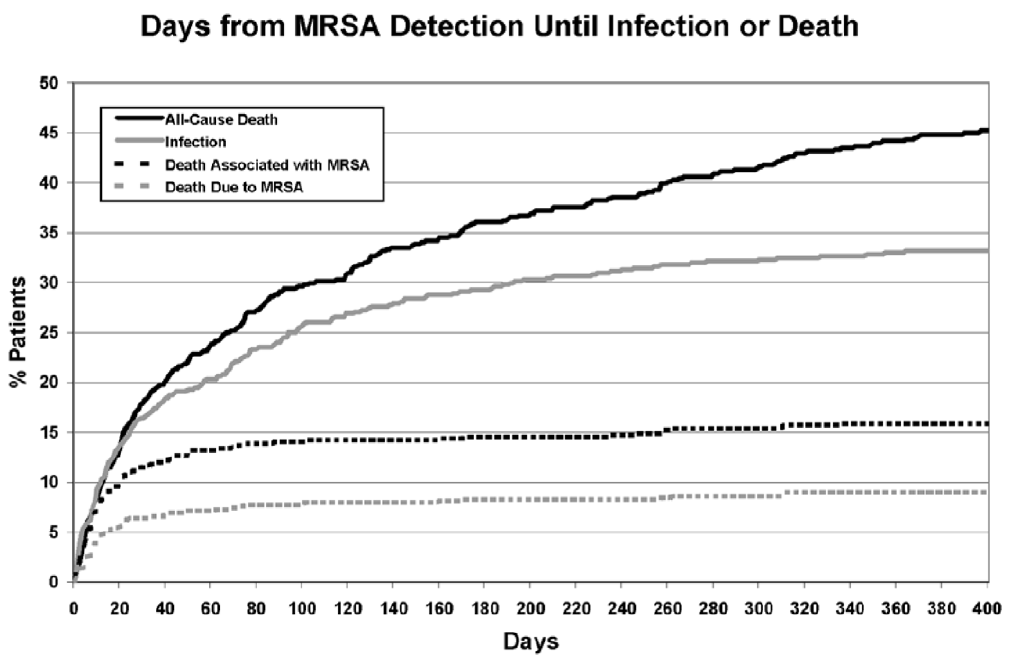
Figure 2. Time to infection or death following discharge from the hospitalization in which methicillin-resistant Staphylococcus aureus (MRSA) was newly-detected.